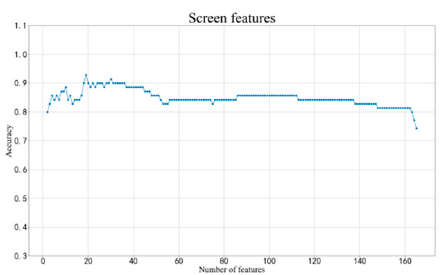
Figure 12. Three-class SBS classification curve of subject 03.